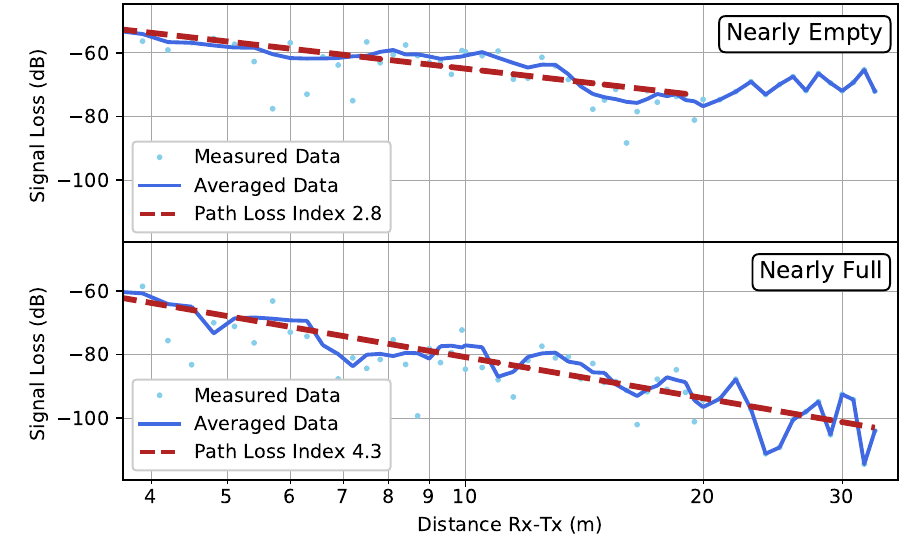
Figure 10. Scenario OW: The low-resolution measured data in the case of a nearly empty parking garage ( top ) and a nearly full parking garage ( bottom ). The average computed by Equation (3) is shown by the solid line, whereas the fitted path loss line is indicated by the dashed